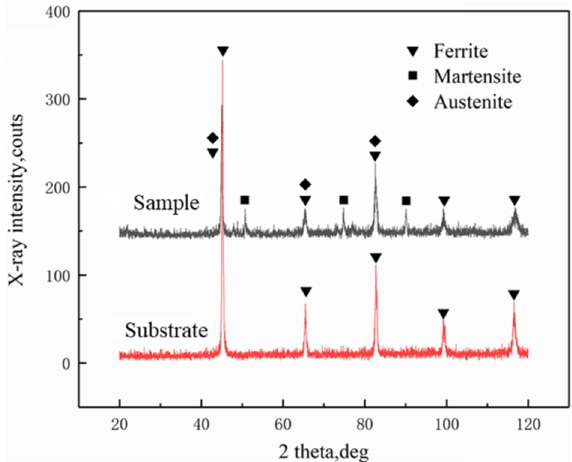
Figure 4. Microstructures of the cross-section in a bionic unit: ( a ) cross-section of the biomimetic unit, ( b ) melting zone, ( c ) phase-transition zone, and ( d ) substrate.